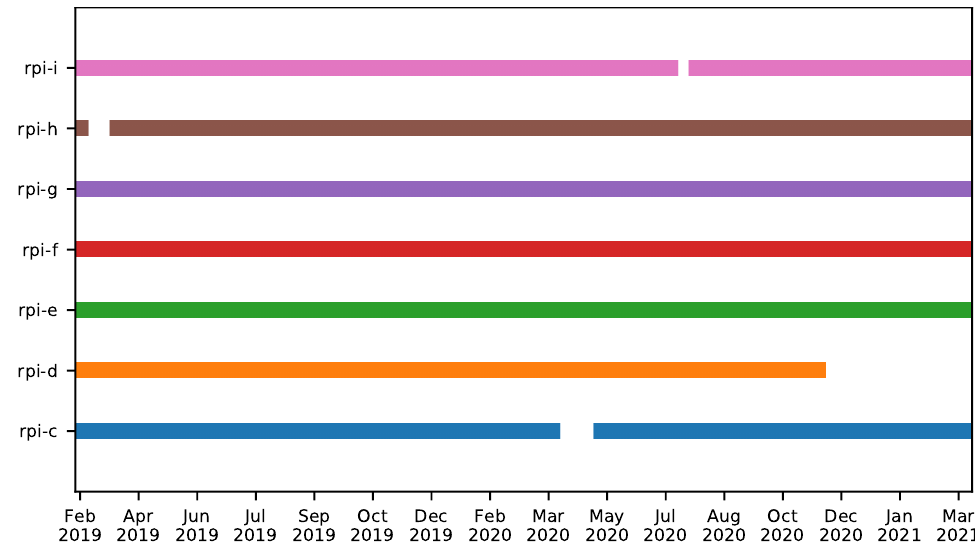
Figure 5. Periods during which the monitoring devices were active and collecting data.